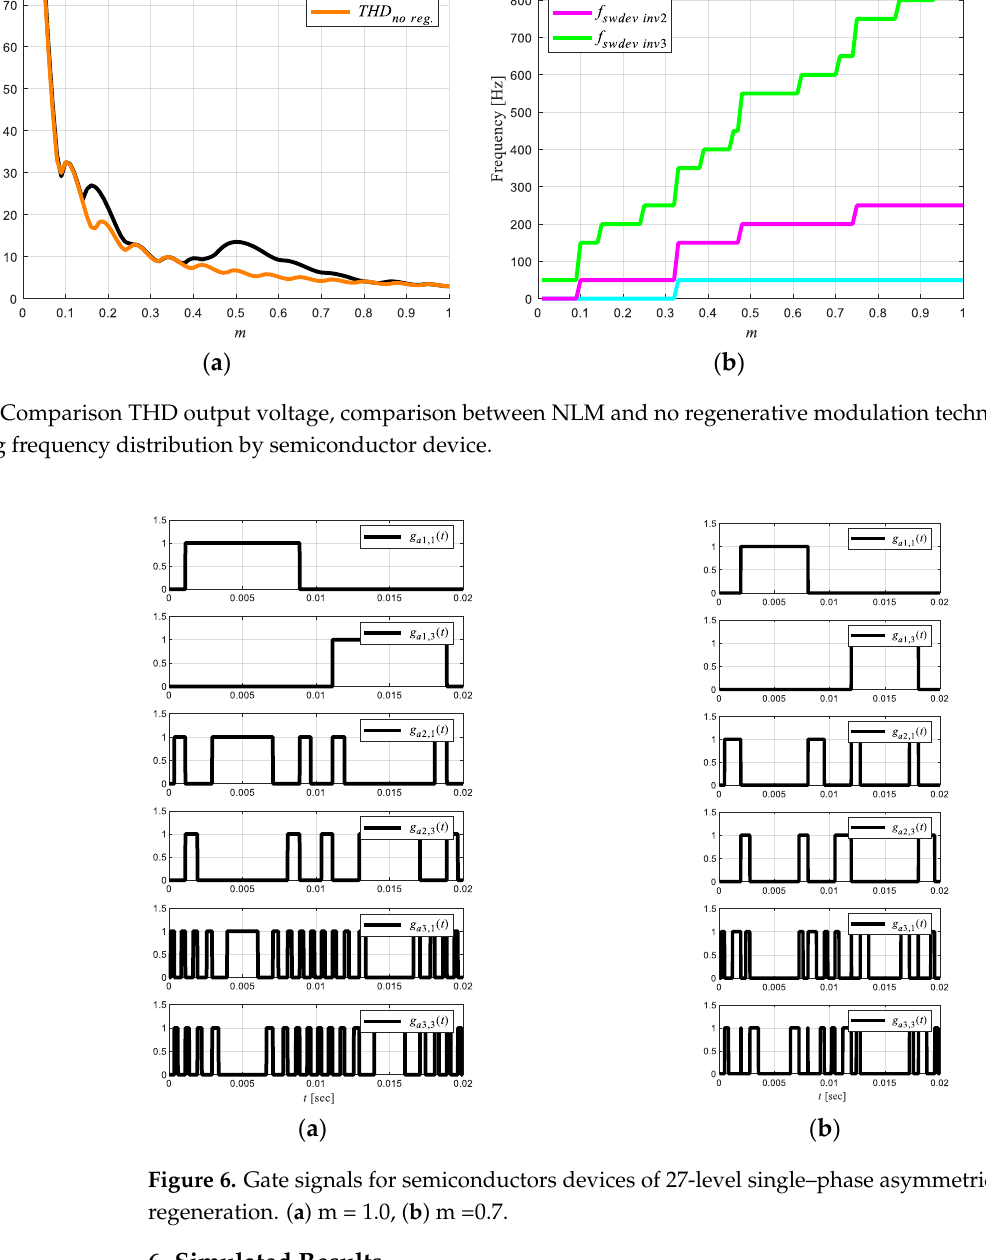
Figure 6. Gate signals for semiconductors devices of 27-level single – phase asymmetric inverter with regeneration. ( a ) m = 1.0, ( b ) m =0.7.